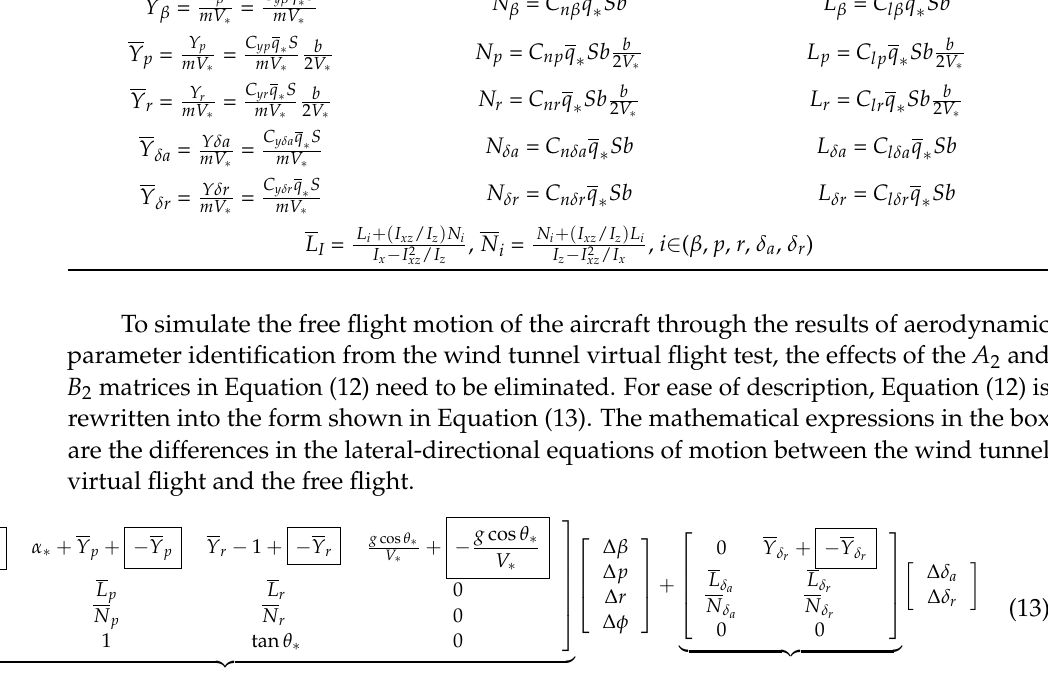
Table 2. Lateral-directional dynamic derivatives. Side Force Derivatives Yawing Moment Derivatives Rolling Moment